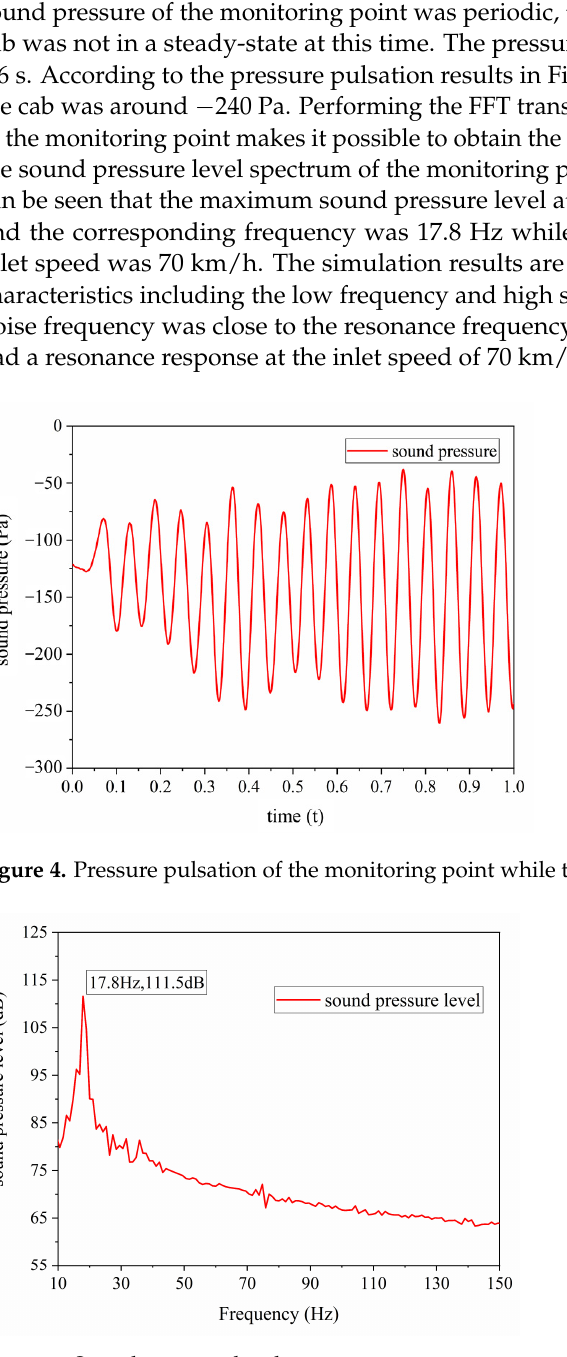
Figure 5. Sound pressure level